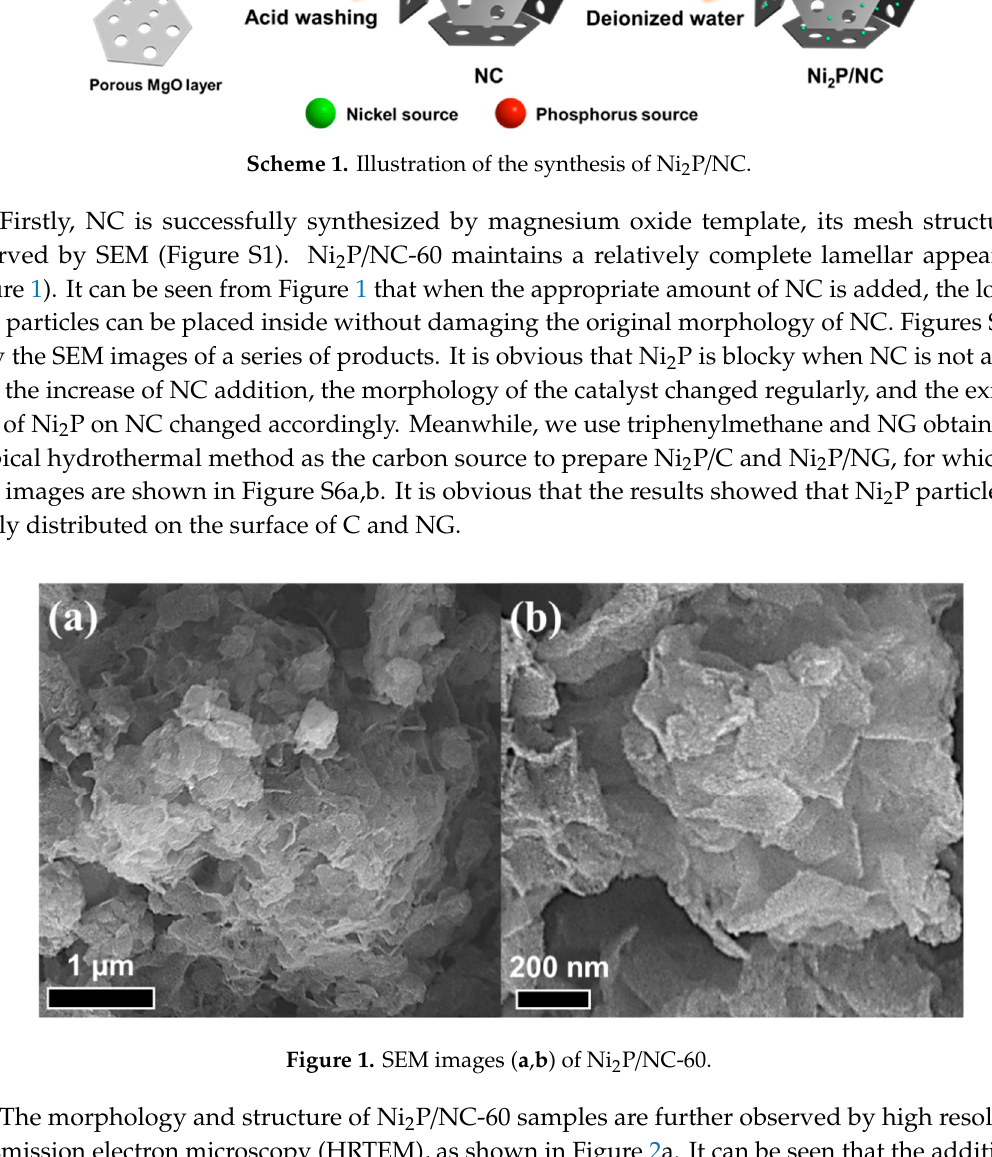
Figure 1. SEM images ( a , b ) of Ni 2 P/NC-60.